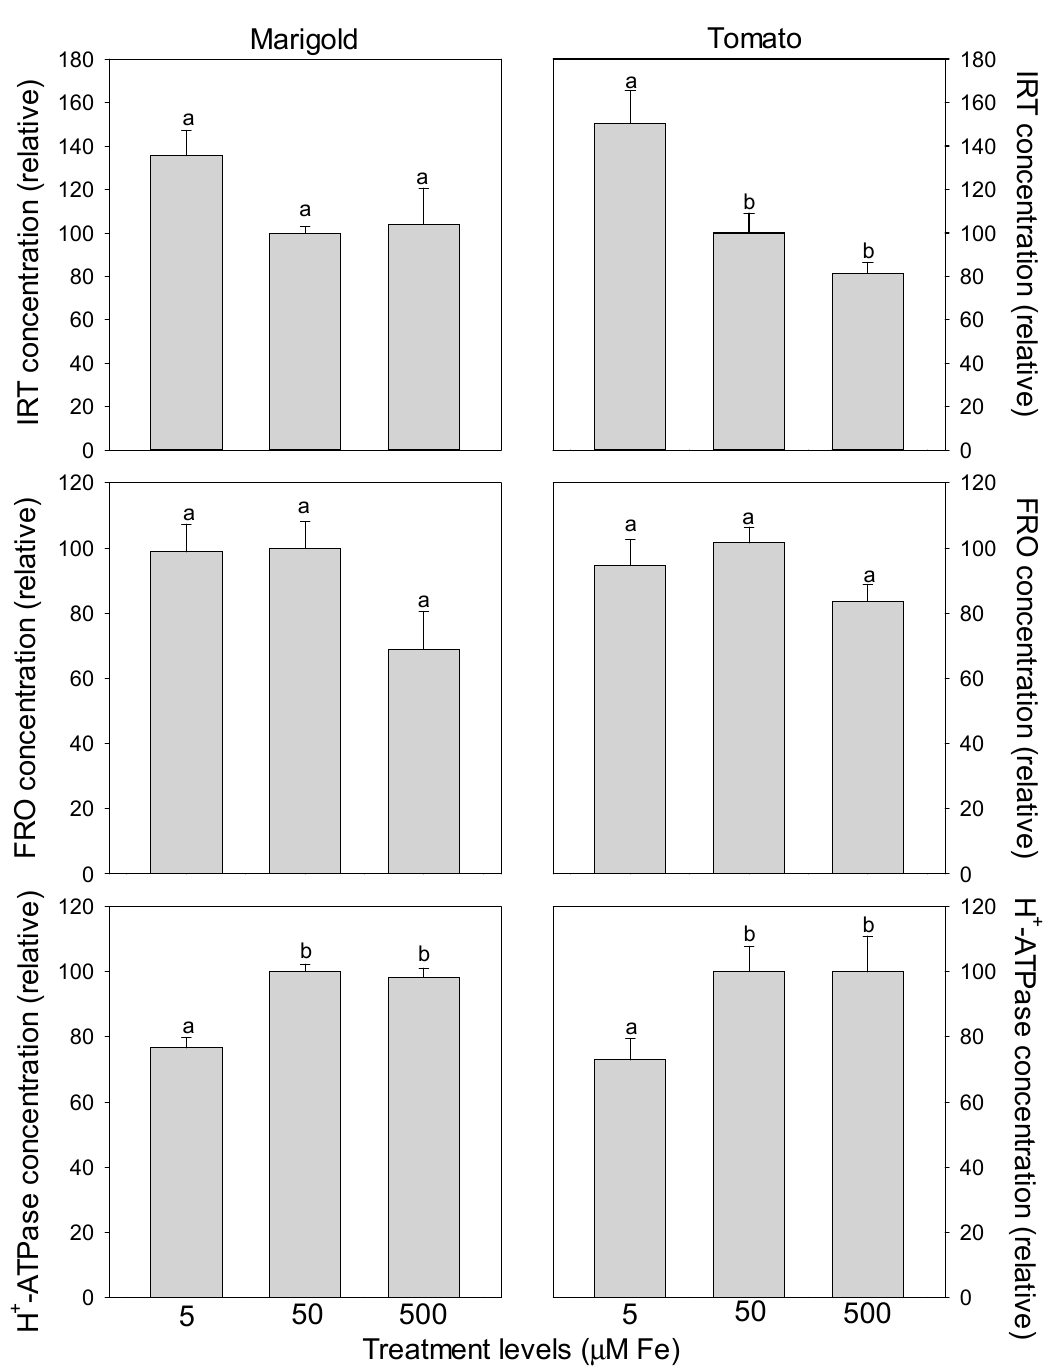
Figure 4. Effects of variation in Fe availability in marigold and tomato on the relative concentration in roots of the Fe-uptake proteins, IRT, FRO, and H + -ATPase. Results are relativized to 50 µM Fe and are means + 1 SE; letters above bars indicate comparisons among treatments (different letters indicate significant differences at p < 0.05).